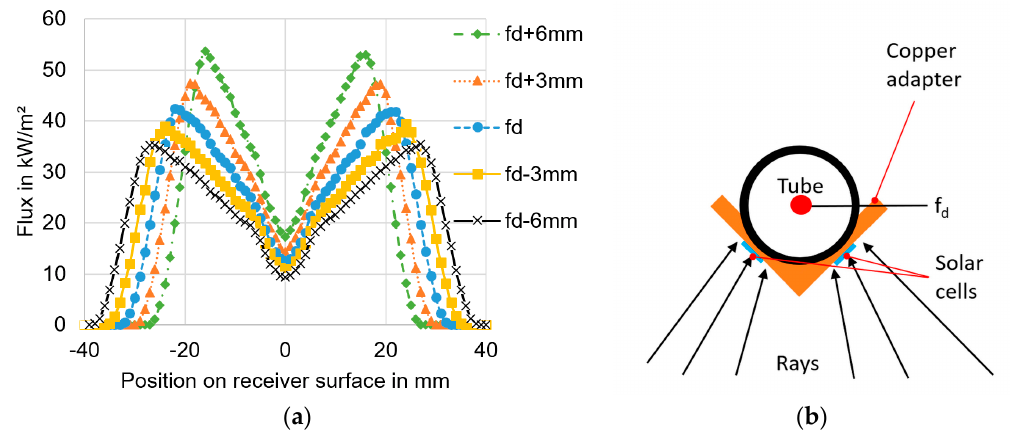
Figure 10. ( a ) Shows the spatial distribution of different receiver positions of the medium concentration setup. ( b ) Depicts the to ( a ) associated simulation setup, where the focal point f d is setup. ( b ) Depicts the to ( a ) associated simulation setup, where the focal point f d is located and how the located and how the absorber tube is positioned. located and how the absorber tube is positioned. absorber tube is positioned. Table 4. Ray tracing simulation of the medium concentration setup to depict the influence of the Table 4. Ray tracing simulation of the medium concentration setup to depict the influence of the concentration setup. ( b ) Depicts the to ( a ) associated simulation setup, where the focal point f d is Table 4. Ray tracing simulation of the medium concentration setup to depict the influence of the absorber position on peak flux and flux distribution. Table 4. Ray tracing simulation of the medium concentration setup to depict the influence of the Table 4. Ray tracing simulation of the medium concentration setup to depict the influence of the absorber position on peak flux and flux distribution. located and how the absorber tube is positioned. Table 4. Ray tracing simulation of the medium concentration setup to depict the influence of the Table 4. Ray tracing simulation of the medium concentration setup to depict the influence of the absorber position on peak flux and flux distribution. absorber position on peak flux and flux distribution. absorber position on peak flux and flux distribution. Position absorber position on peak flux and flux distribution. absorber position on peak flux and flux distribution. Table 4. Ray tracing simulation of the medium concentration setup to depict the influence of the absorber position on peak flux and flux distribution.